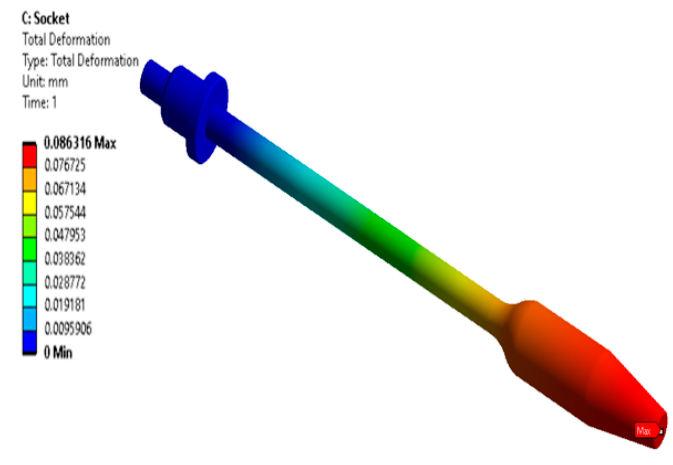
Figure 9. Analysis results for the rope socket.